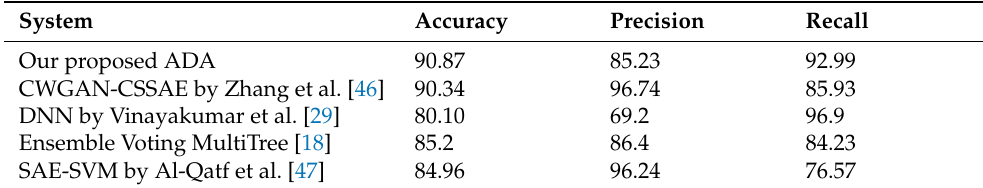
Table 13. Compare ADA with other research in NSL-KDD